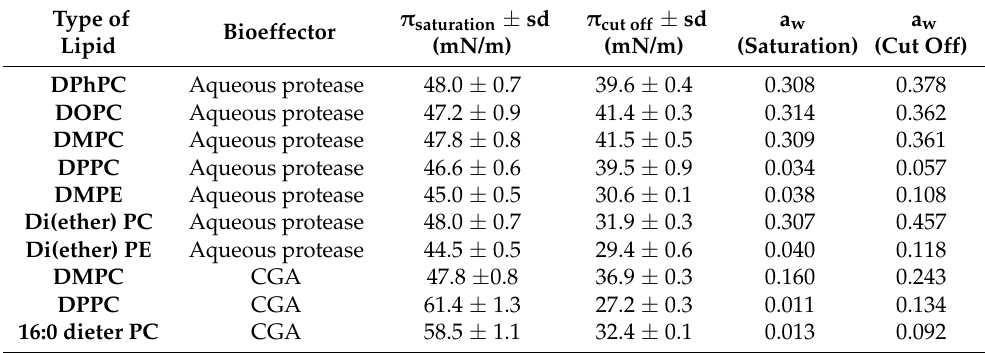
Table 1. Comparison of surface pressure and the corresponding water activities at the collapse and cut off pressures [55,56]. ± sd π saturation ± sd π a w Type of a w cut off Bioeffector (mN/m) (mN/m) Lipid (Saturation) (Cut Off) DPhPC Aqueous protease 48.0 ± 0.7 39.6 ± 0.4 0.308 0.378 DOPC Aqueous protease 47.2 ± 0.9 41.4 ± 0.3 0.314 0.362 DMPC Aqueous protease 47.8 ± 0.8 41.5 ± 0.5 0.309 0.361 DPPC Aqueous protease 46.6 ± 0.6 39.5 ± 0.9 0.034 0.057 DMPE Aqueous protease 45.0 ± 0.5 30.6 ± 0.1 0.038 0.108 Di(ether) PC Aqueous protease 48.0 ± 0.7 31.9 ± 0.3 0.307 0.457 Di(ether) PE Aqueous protease 44.5 ± 0.5 29.4 ± 0.6 0.040 0.118 DMPC CGA 47.8 ± 0.8 36.9 ± 0.3 0.160 0.243 DPPC CGA 61.4 ± 1.3 27.2 ± 0.3 0.011 0.134 16:0 dieter PC CGA 58.5 ± 1.1 32.4 ± 0.1 0.013